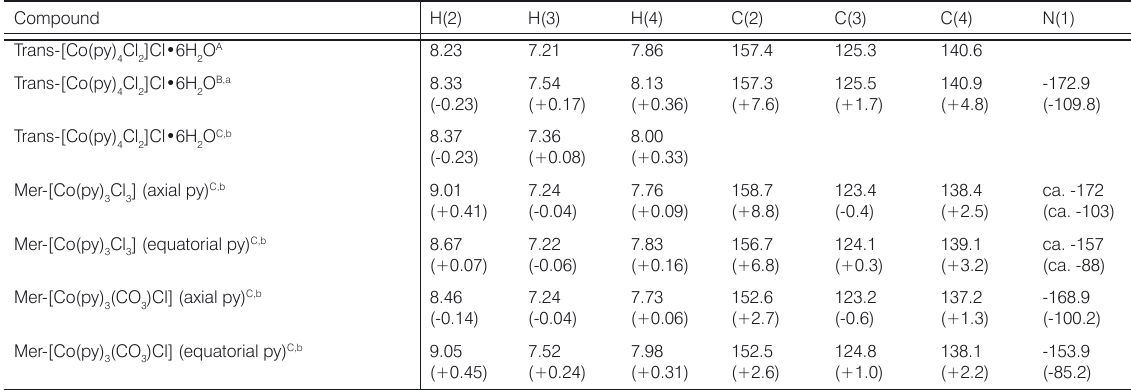
DMSO-d (B), CDCl (C); the relevant coordination shifts (in parentheses: ∆ 6 3 in the same solvent (except for D